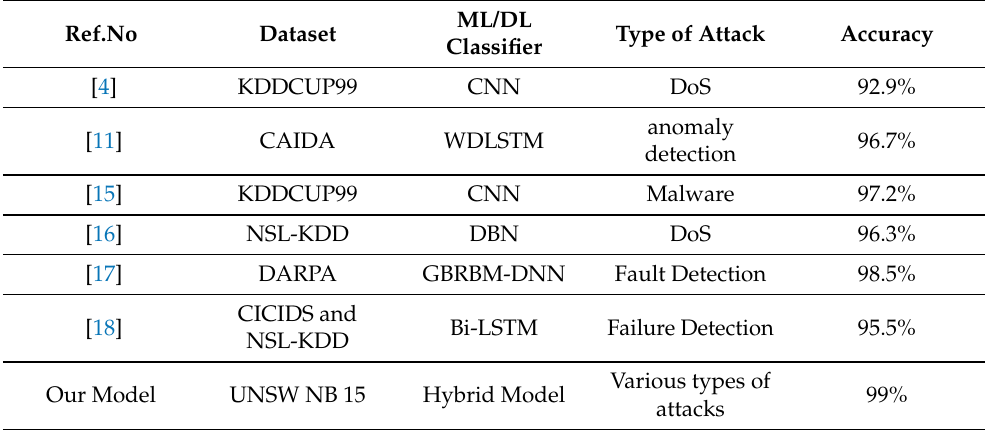
Table 1. Comparison of Attacks with different